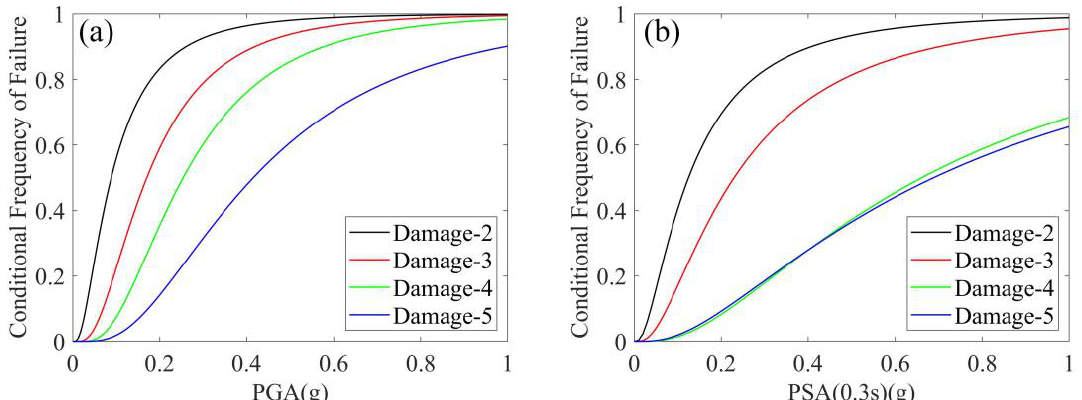
Figure 9. ( a , b ) Empirical fragility curves for stone masonry buildings in Nepal considering PGA and PSA0.3s as intensity measures. PSA0.3s as intensity measures.